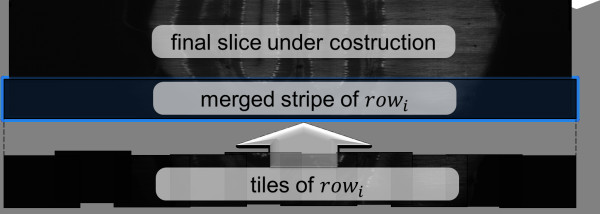
Memory management in the merging step. The whole volume is processed a layer at the time, each composed by the number of slices needed to generate the lowest resolution (e.g. 32 slices for a reduction of 5 times). For each layer, stacks are read row-wise and merging is performed slice by slice. When one slice group of every tile in row i of the tile matrix have been read, adjacent tiles in the groups are merged using the blending algorithm described in the Algorithms section. This produces a horizontal stripe, which is merged with the ones previously generated from the slices of the preceding rows, so producing larger stripes until the whole slice of the final image representation is obtained.